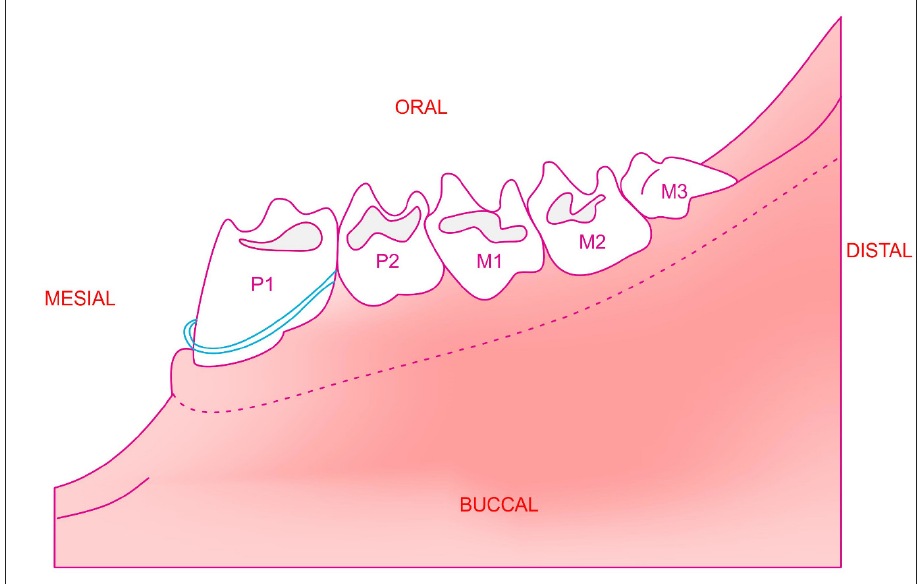
Fig. 1. A ligature was tied around the first mandibular premolar to promote gingival irritation and induce experimental